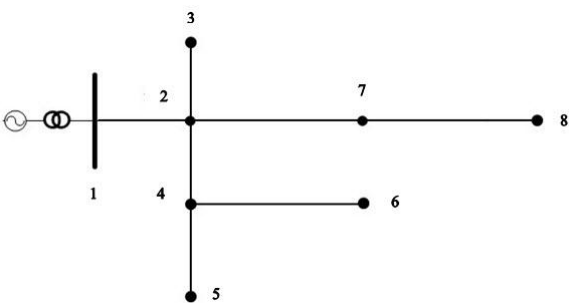
Figure 15. Single-line diagram of test feeder 2. Table 6. Simulated distribution feeder.